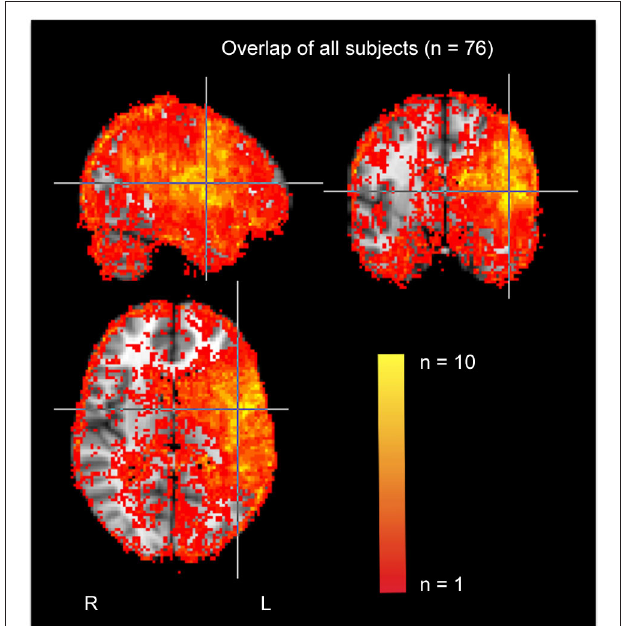
FIGURE 1 | Group map of infarcted/hypoperfused voxels in the entire sample .